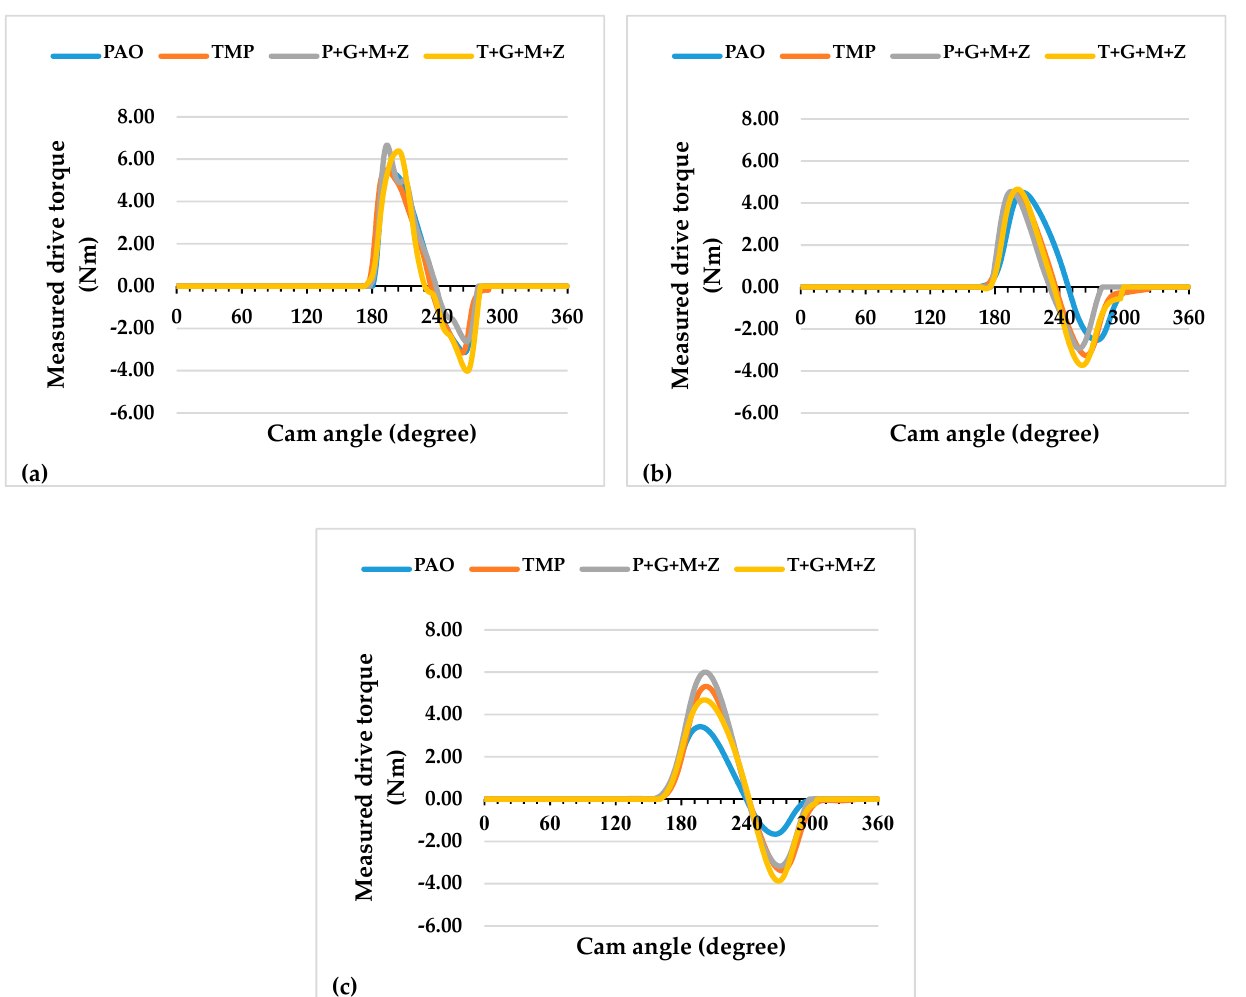
Figure 13. Instantaneous exhaust camshaft drive torque with a-C:H:W-coated tappets and a-C:H:W-coated camlobes at a lubricant temperature of 90 °C and camshaft speeds of ( a ) 400 RPM, ( b ) 800 RPM, and ( c ) 1200 RPM.